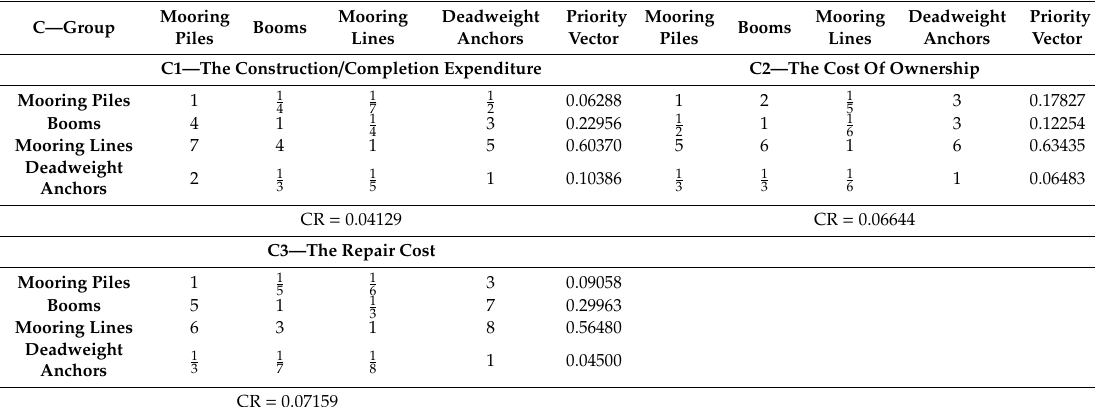
Table 8. Comparison matrix alternative for Cost criteria group.